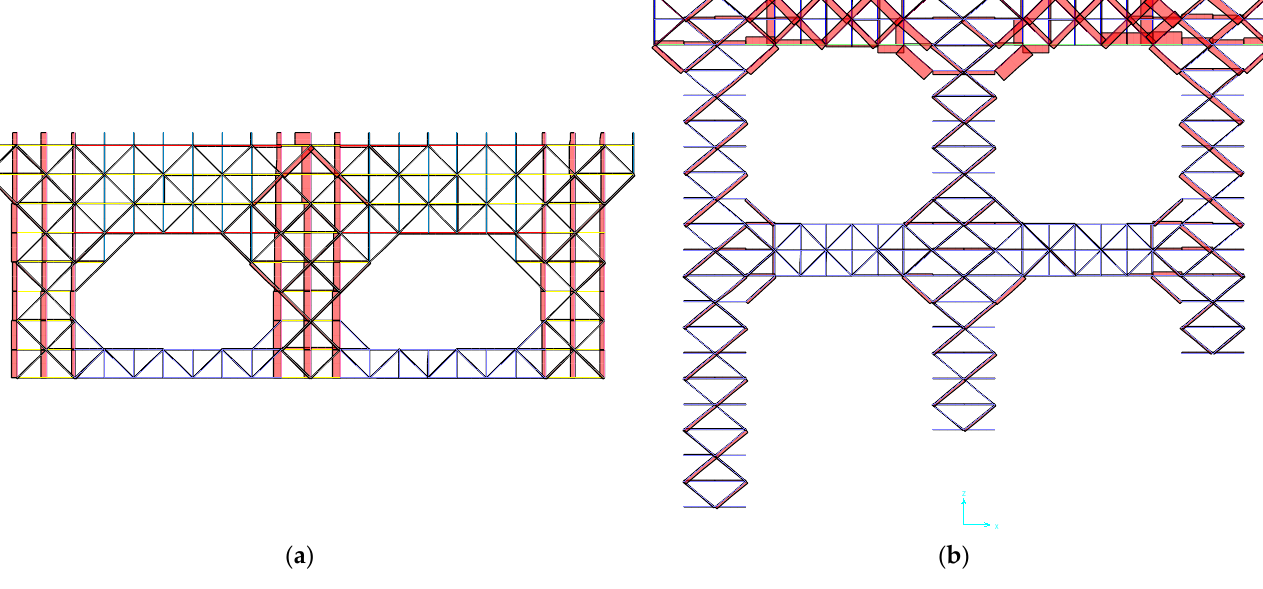
Figure 13. Maximum axial force diagram of the universal rods of the tower located on the right bank: ( a ) cable tower; ( b ) buckle tower. Table 10. Axial force of universal rods of tower (unit: